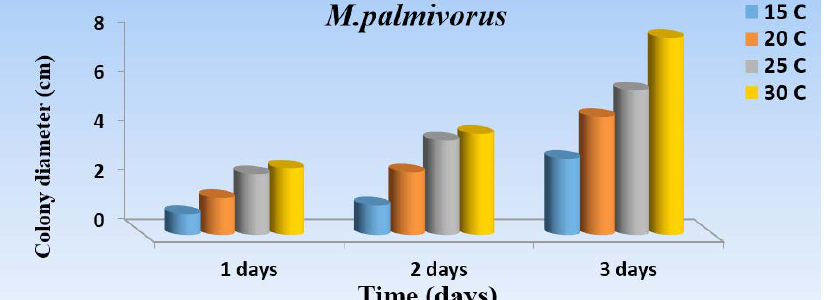
Fig. 4. Effect of different temperatures: 15 o C (A), 20 o C (B), 25 o C (C), and 30 o C (D) in the growth diameter of M. palmivorus on PDA after 3 days of incubation (LSD(0.05)=0.263)